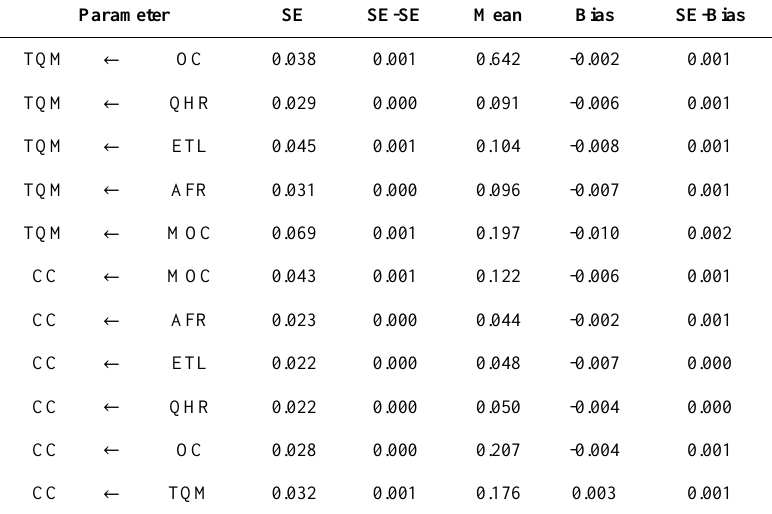
Table 4. Testing bootstrap with 30.000 samples for factors affecting total quality management and competitive capability